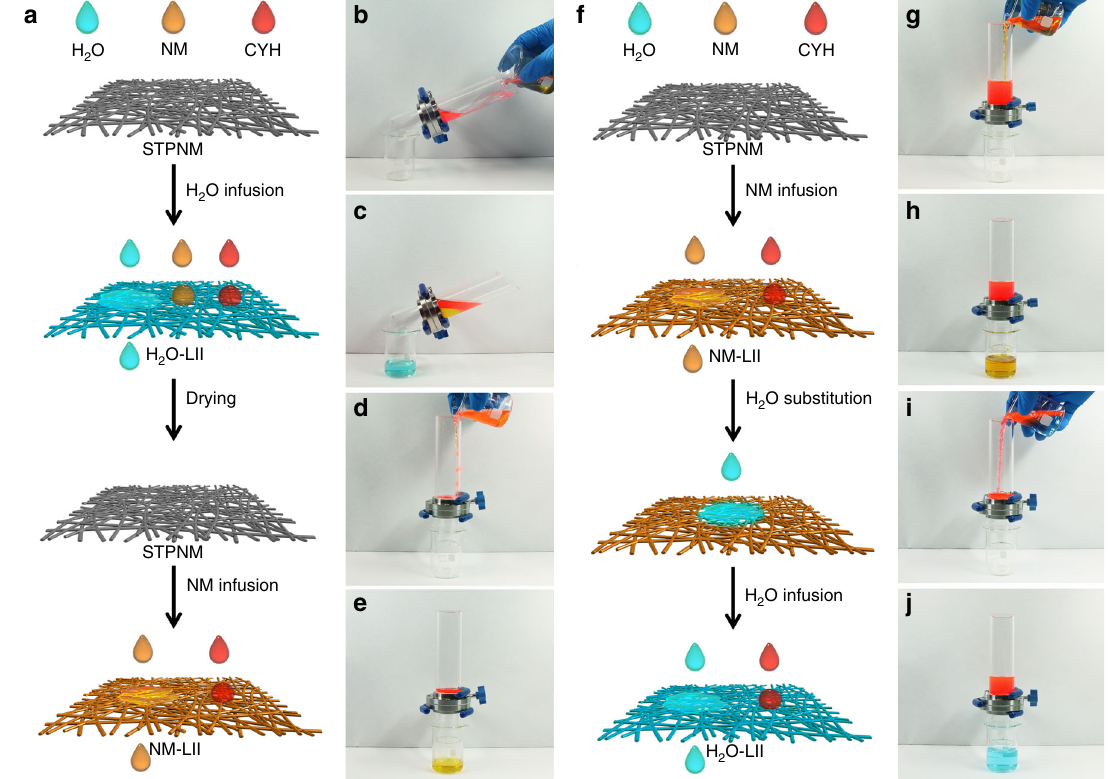
Fig. 2 Separation of multiphase liquids. a Schematic illustration of multiphase liquids separation (water, CYH and NM). Water selectively permeates through the water-LII, while NM and CYH are retained. After that, the water-LII is dried and then infused by NM to form NM-LII. The NM-LII allows the passage of NM, but retains CYH. ( b – e ) Demonstration of the separation process of the multiphase liquids. b The mixture of water, NM and CYH (volume ratio 1:1:1) is poured onto a water-infused STPNM. c The separated water is collected and no other colorful liquids are observed. d , e After the drying and NM infusion process, the separation of CHY and NM is achieved by NM-LII membrane and no red liquid is visible in the collector. f Schematic illustration of successive separation of two pairs of immiscible liquids (NM/CYH and water/CYH) over one STPNM. NM selectively permeates through the NM-LII, while CYH is blocked. Then, a small quantity of water is added to substitute NM in the NM-LII, making it into water-LII. The water-LII allows the passage of water, but retains CYH. g – j Presentation of the successive separation process. g , h Mixture of CYH and NM (volume ratio 1:1) is separated by NM-infused STPNM and only yellow liquid can be observed in the beaker. i , j After the adding of a small quantity of water, mixture of water and CYH (volume ratio 1:1) is separated by water-LII, and no red liquid is visible in the